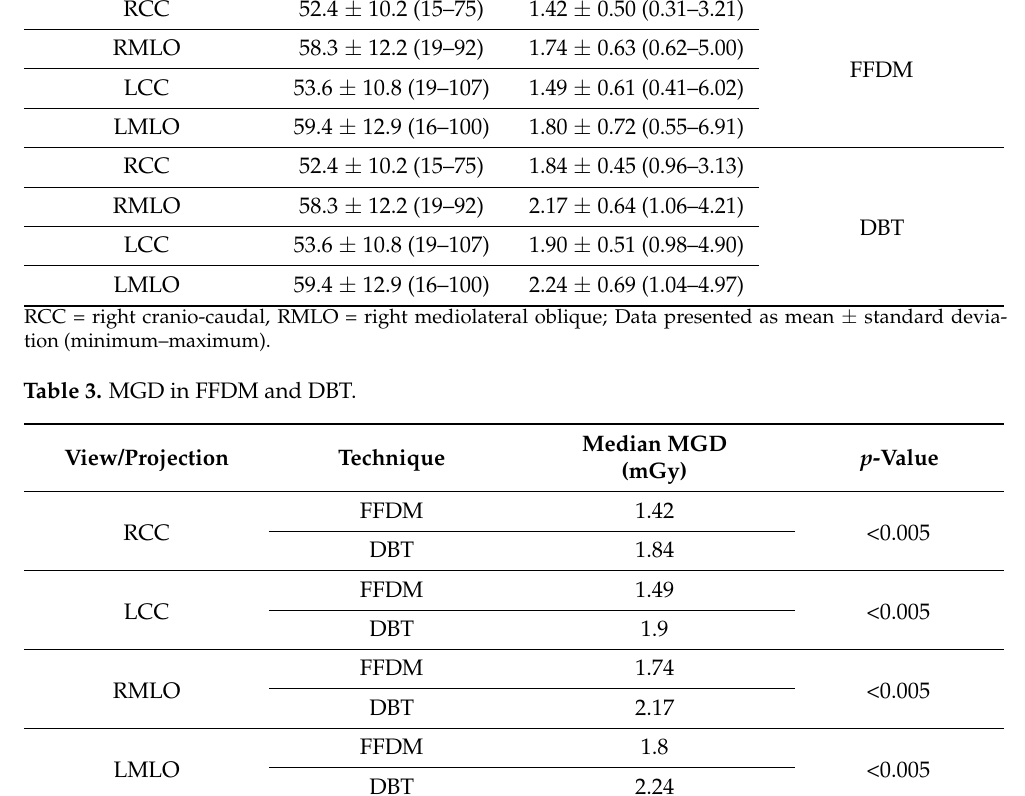
Table 2. Compressed breast thickness (CBT) and mean glandular dose (MGD) per exposure for each projection.